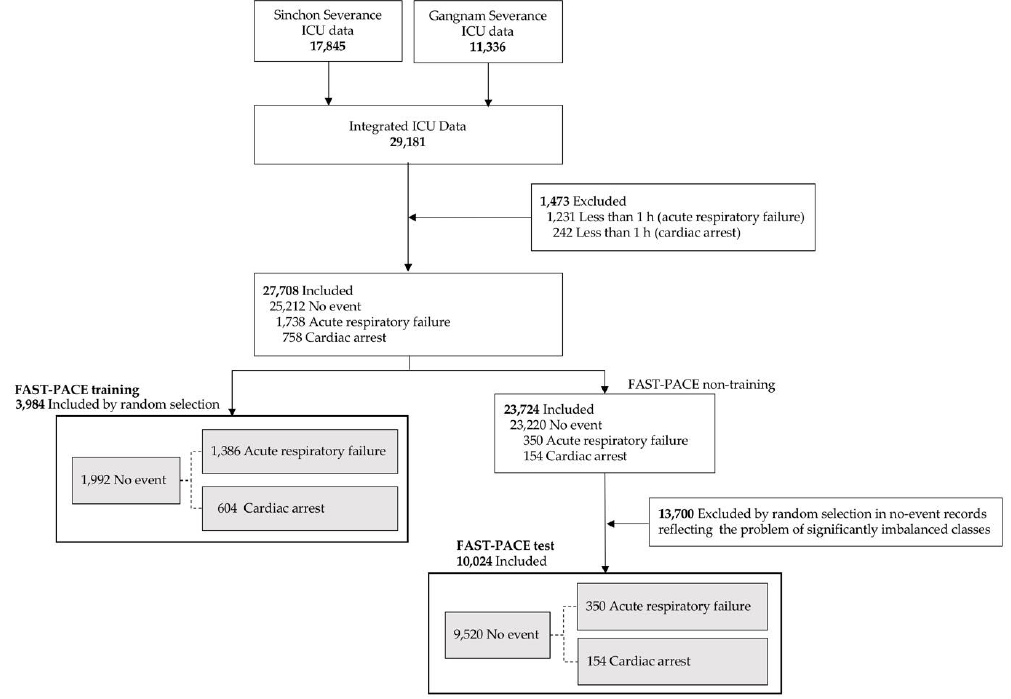
Figure 1. Studied populations. ICU = intensive care unit; FAST-PACE = Feasible Artificial intelligence with Simple Trajectories for Predicting Adverse Catastrophic Events.